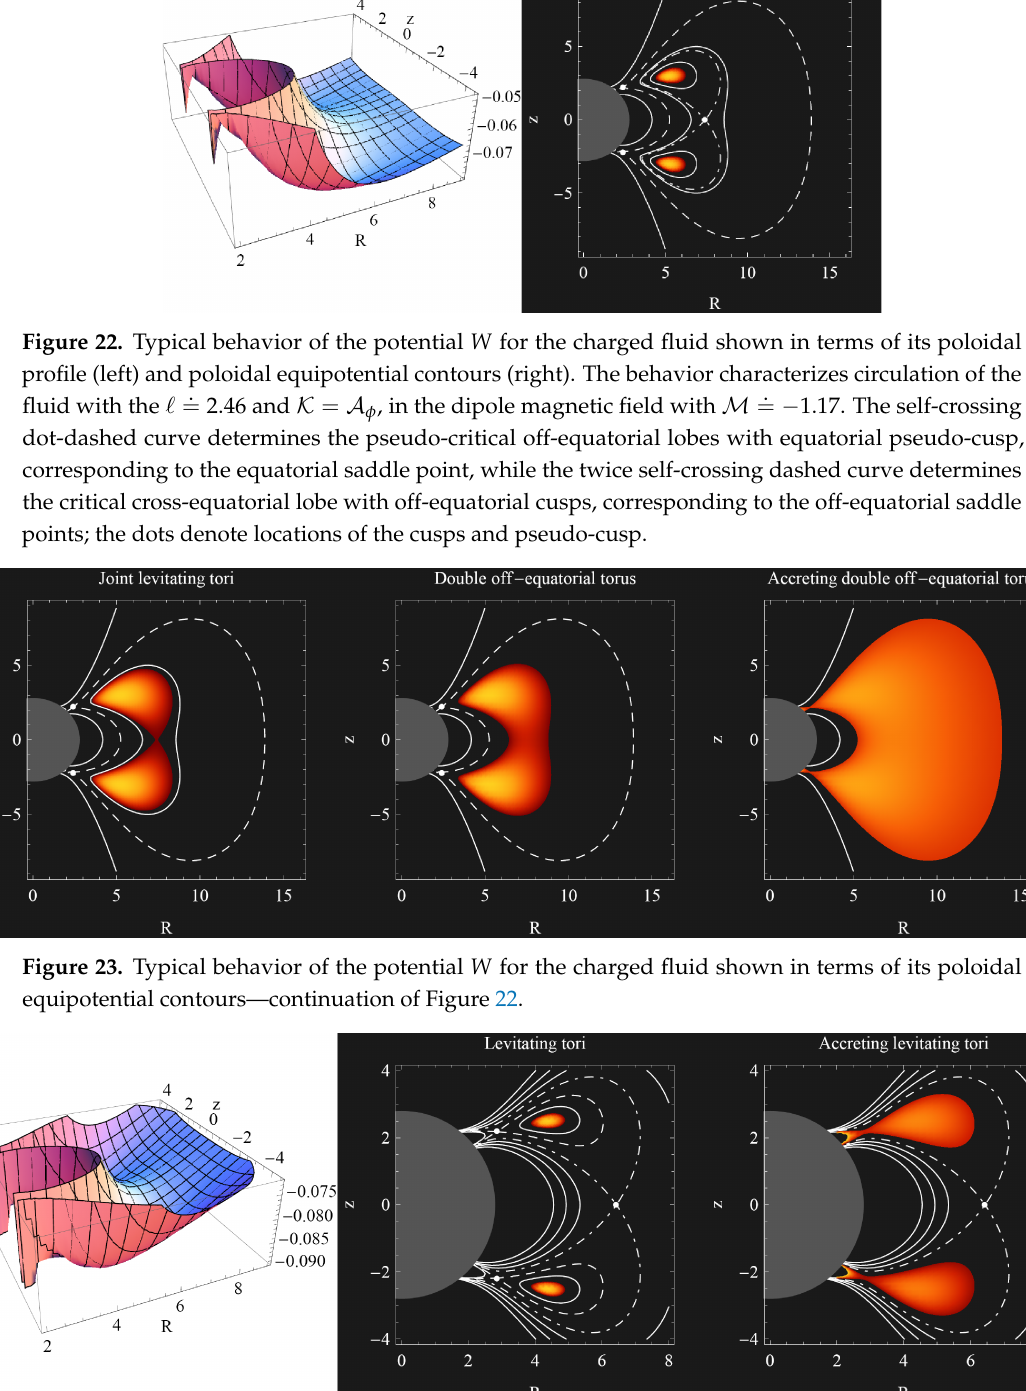
Figure 24. Typical behavior of the potential W for the charged fluid shown in terms of its poloidal profile and poloidal equipotential contours. The behavior characterizes circulation of the fluid with . . (cid:96) = 2.46 and = = , in the dipole magnetic field with 0.95. The twice self-crossing dashed K A φ M − curve determines the critical off-equatorial lobes with the off-equatorial cusps, corresponding to the off-equatorial saddle points, while the self-crossing dot-dashed curve determines the pseudo-critical off-equatorial lobes with the equatorial pseudo-cusp, corresponding to the equatorial saddle point; the dots denote locations of the cusps and